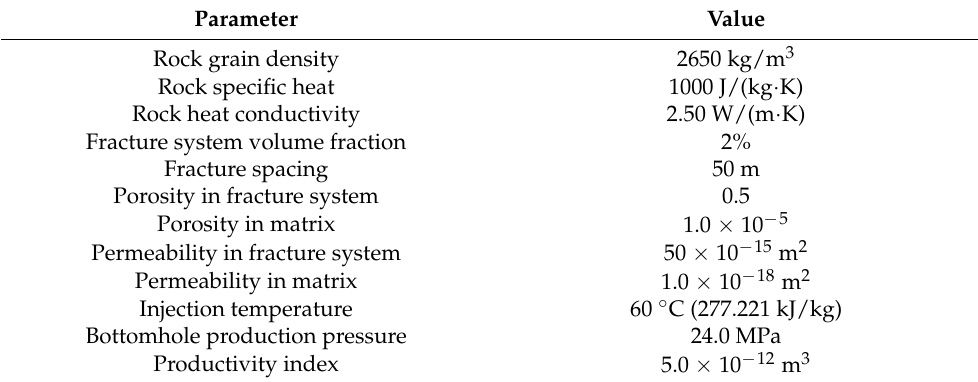
Table 2. EGS reservoir properties at well DR3 in the Gonghe Basin geothermal area [37].